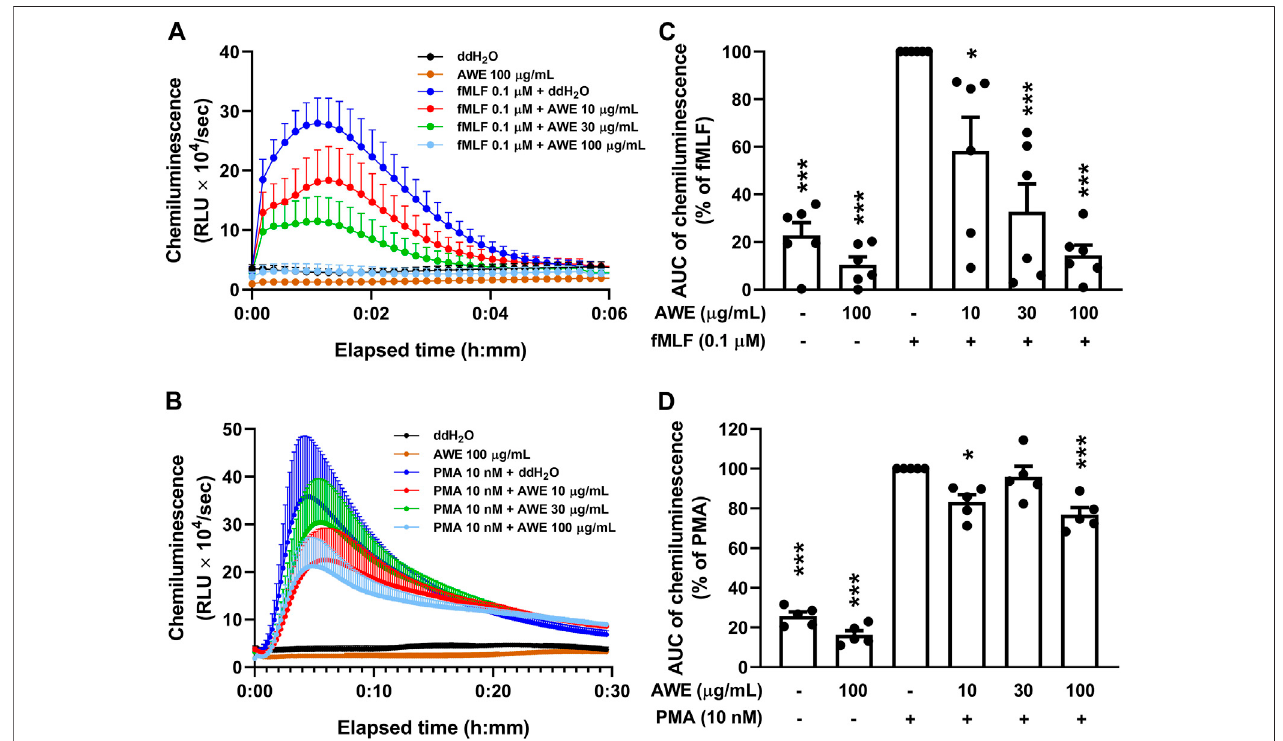
FIGURE 5 | AWE both inhibited neutrophil activation and scavenged ROS generation in fMLF-activated human neutrophils in luminol-enhanced chemiluminescence assay.Human neutrophil (7 × 10 5 cells/mL) were incubated with ddH 2 O (as the control) or AWE (10, 30, and 100 μ g/ml) for 5 min and stimulated with (A) fMLF (0.1 μ M) for another 6 min or (B) PMA (10 nM) for 30 min. The area under curve (AUC) of chemiluminescence in (C) fMLF or (D) PMA are shown as the mean ± S.E.M. ( n (cid:2) 5 or 6). Statistical analysiswas conducted using the one-way analysisofvariance (ANOVA),followedbyTukey ’ s multiple comparisontestif there were statistical differences in the results of ANOVA. Adjusted p -values of Tukey ’ s multiple comparison tests were de fi ned as *** p < 0.001 and * p < 0.05 compared with the control.